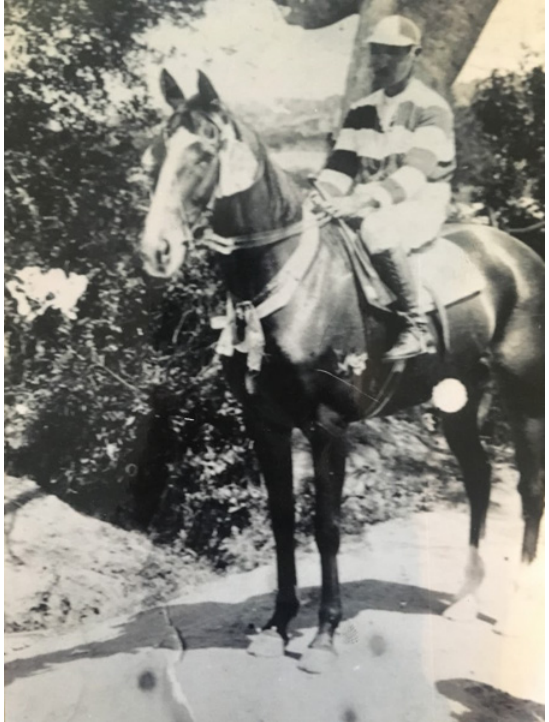
Figure 4 One of the remaining photographs of Jeannette’s father, Tomiki Yokoyama, on his prized Gigolette, preserved and handed down to Jeannette by her mother © Jeannette Yokoyama. Used with